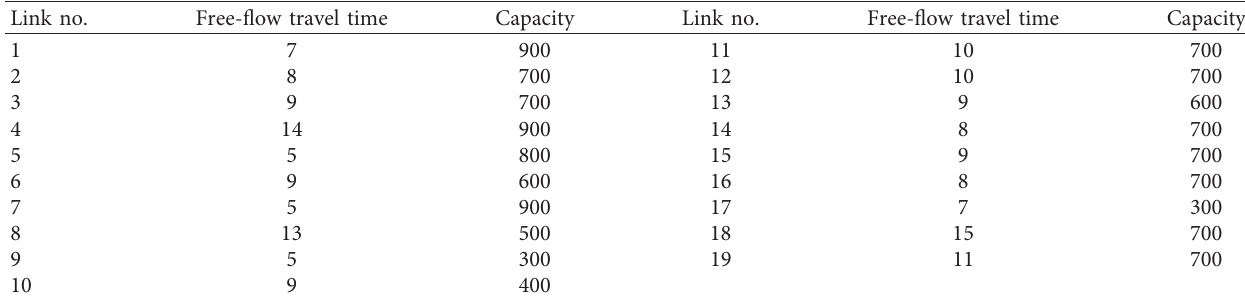
Table 4: Parameters of links.